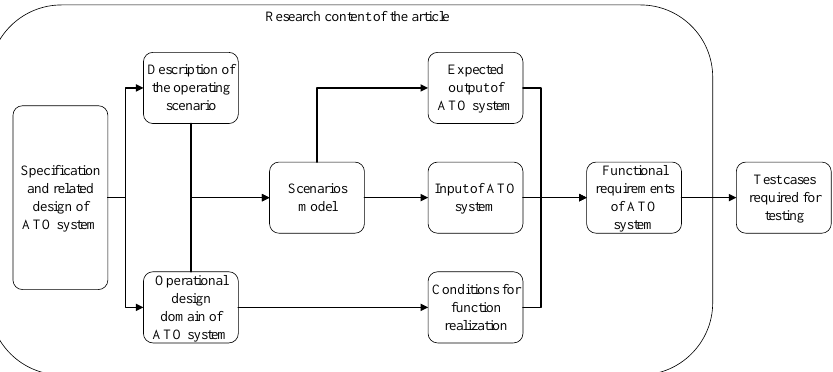
Figure 1. Diagram of the research content of the